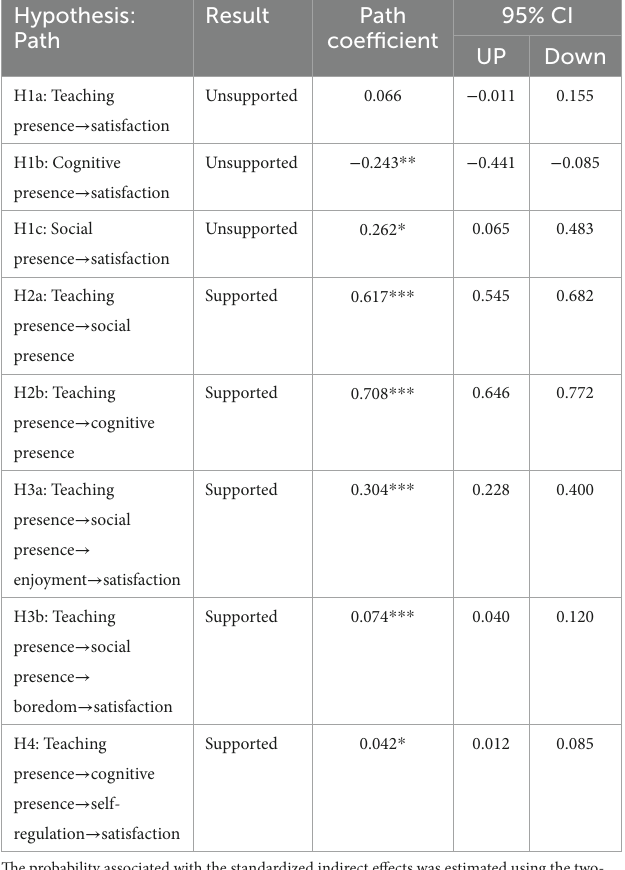
TABLE 3 Standardized direct and indirect effect values of the determinants on